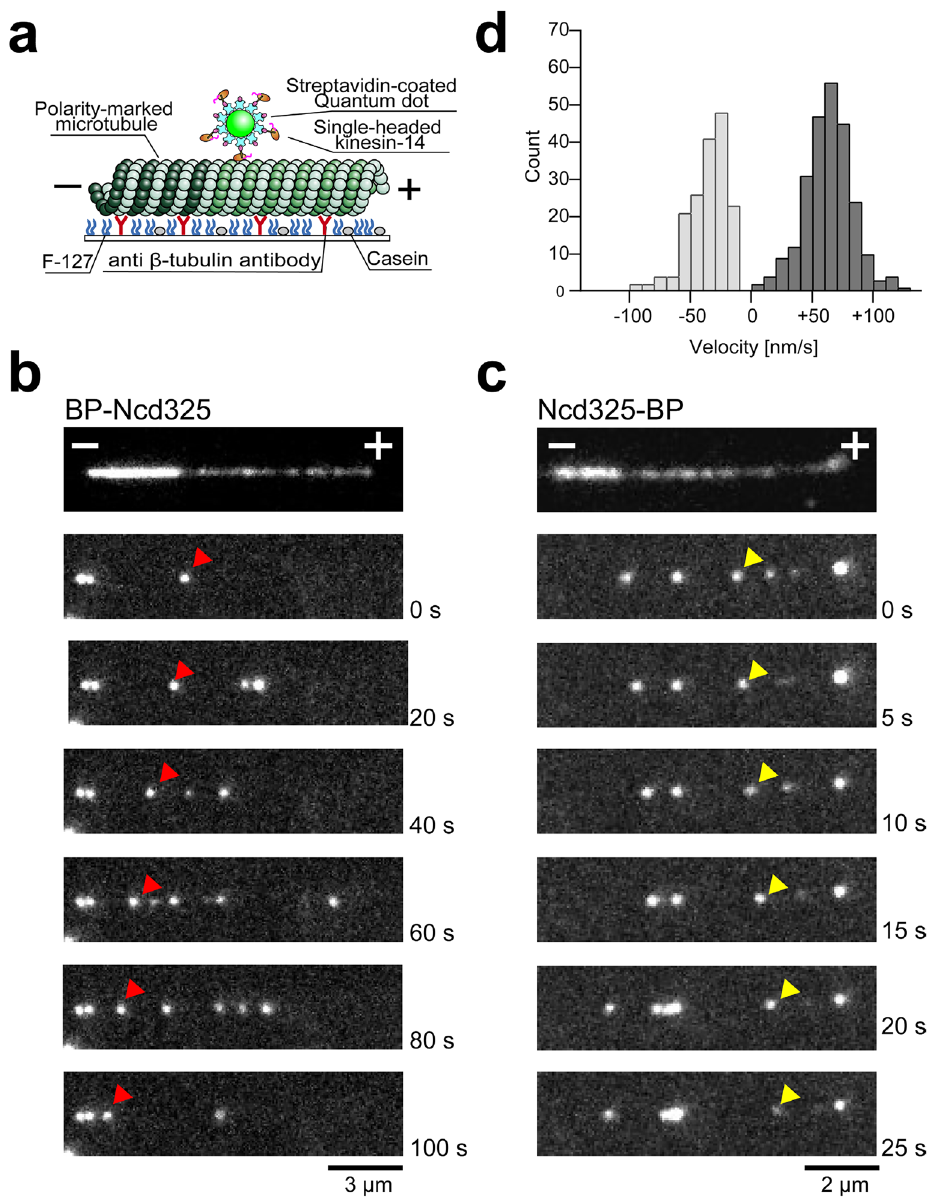
Figure 3. QD assay of N- or C-linked monomeric Ncd325. ( a ) Scheme of the quantum dot (QD) assay. Streptavidin-coated QDs, which are linked to avi-tag fused Ncds via either an N- or C-terminal avi-tag and biotin-streptavidin linkage, move on polarity-marked microtubules. ( b , c ) Sequential images of QDs moving on polarity-marked microtubules. QD-BP-Ncd325 (red arrow head, b ) move towards the bright minus-end of the microtubule and Ncd325-BP-QD (yellow arrow head, c ) towards the dim plus-end of the microtubule. ( d ) A histogram of motility velocities of a QD coated with N-linked monomeric Ncd (gray) and C-linked monomeric Ncd (black). Mean velocities for QD-BP-Ncd325 and Ncd325-BP-QD are − 37 ± 16 nm s −1 (mean ± SD, n = 171) and + 63 ± 20 nm s −1 (mean ± SD, n = 248), respectively. The plus (+) and minus (−) signs refer to the plus-end and minus-end of the